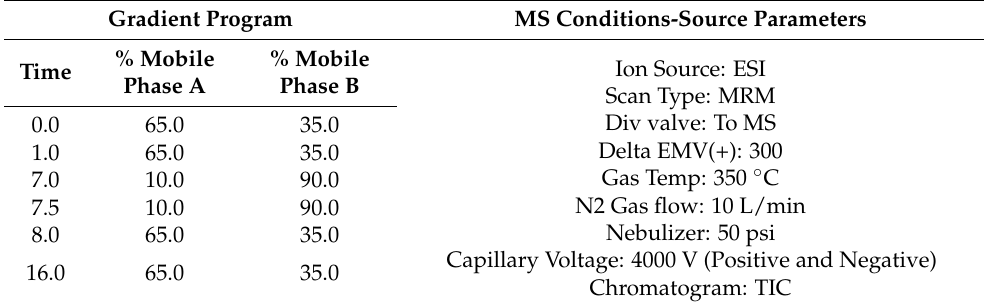
Table 6. Gradient program and MS conditions: Source parameters.